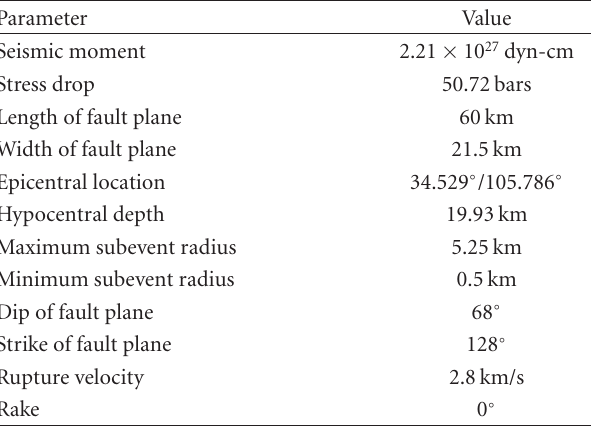
Table 4: The Chinese seismic intensity scale for peak ground acceleration [57].